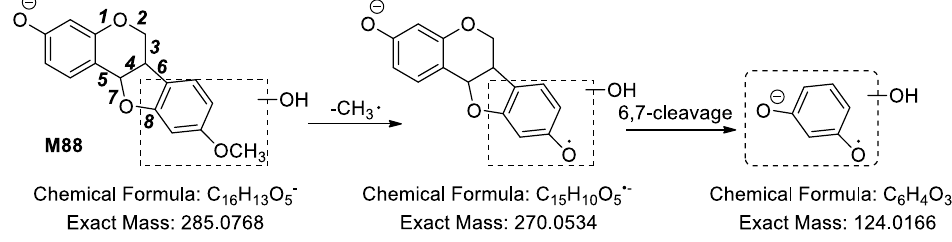
Figure 8. The proposed fragmentation pathways of M88 in ESI−